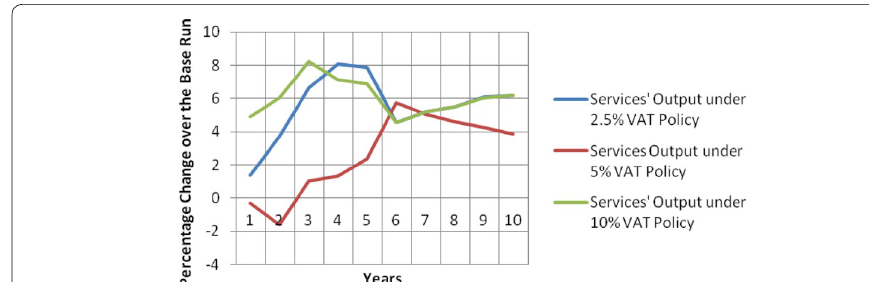
Fig. 21 Impact of different VAT policies on services’ output